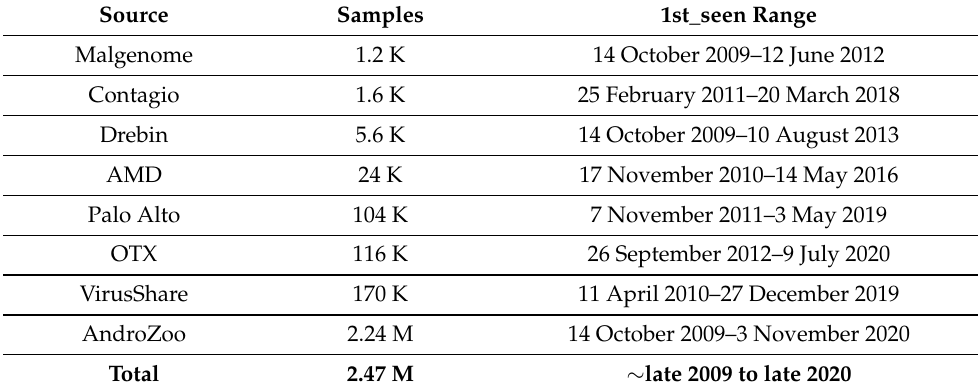
Table 6. Datasets used in our analysis. The 1st_seen range is according to VT and for the samples we collect (as opposed to the samples in the entire repository, such as in Table 4). For instance, in the case of VirusShare, it relates to the snapshot of 170 K samples. Total refers to total apps used in the experiments after discarding duplicates. Source Samples 1st_seen Range